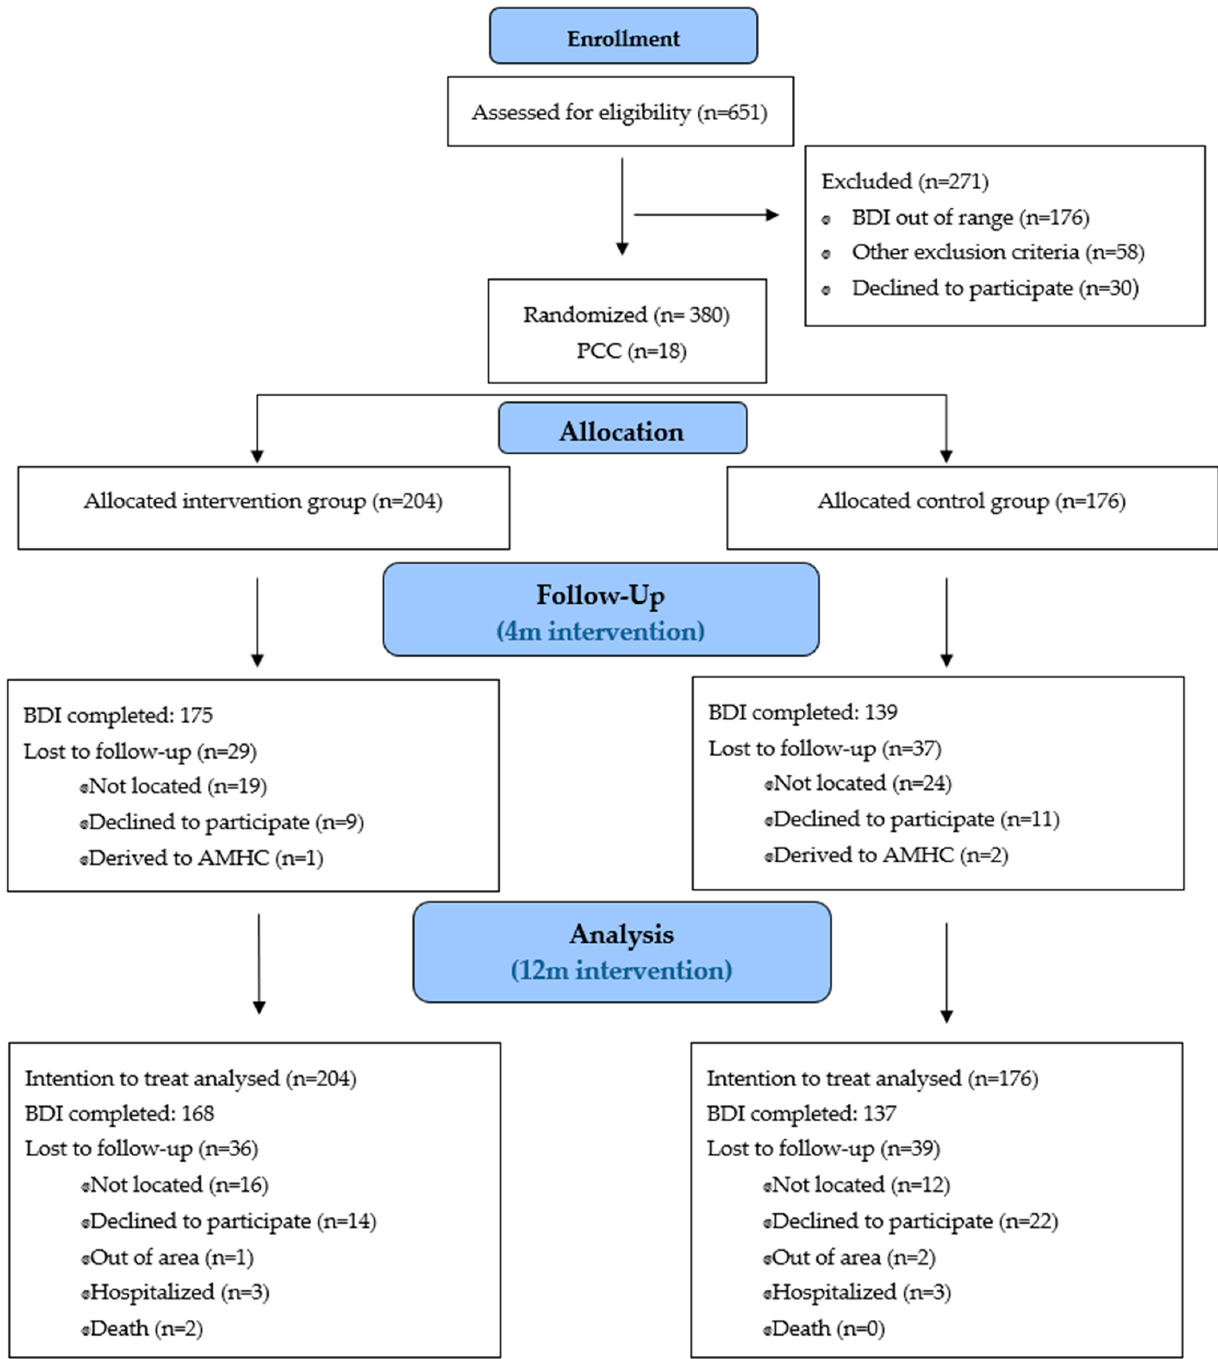
Figure 1. The flow of participants. Abbreviations: PCC, primary care center. AMHC, Adult mental health center. BDI, Beck depression inventory.